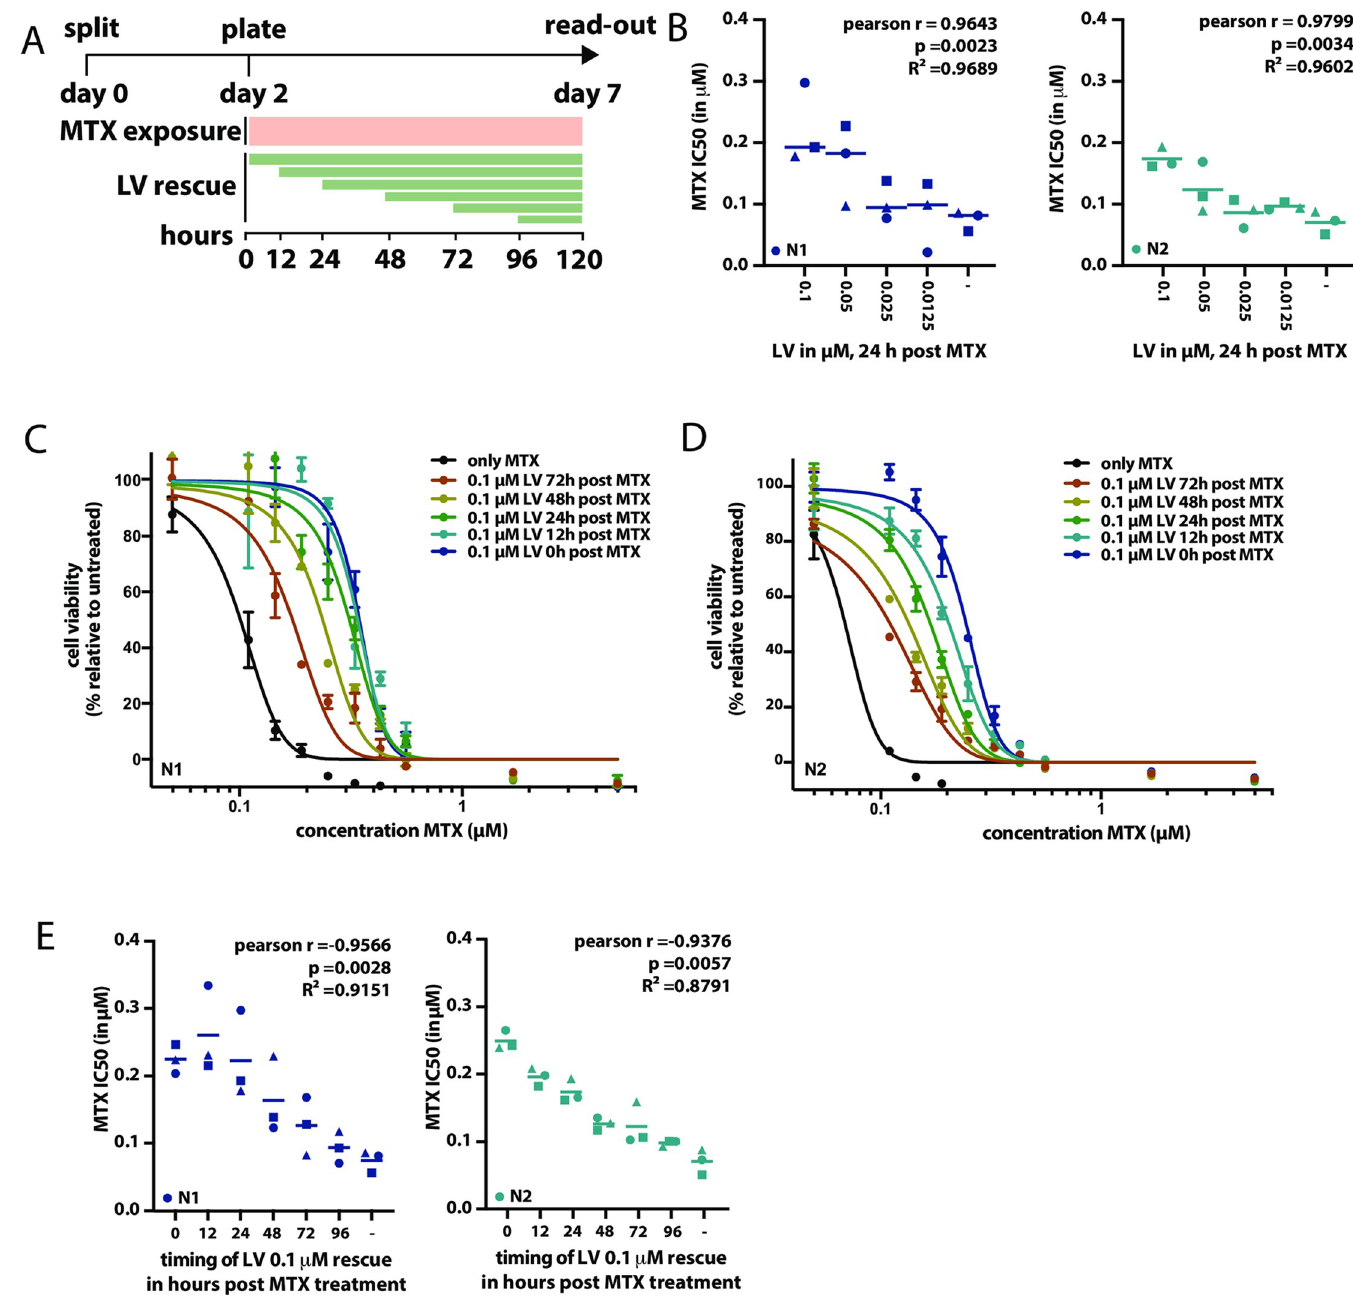
Fig 2. MTX-induced toxicity in oral mucosa organoids can be rescued by the addition of LV, in both a timing- and dosing-dependent manner. A. Schematic outline of the experimental set-up applied to assess the effect of LV rescue initiated post MTX exposure toxicity in vitro . Organoids were split on day 0, left to recover for two days, subsequently filtered, counted and plated in 384 well format to be exposed to MTX for five days (with or without LV added on variable timepoints after the start of MTX exposure). On day 7, viability readout was performed. As such, organoids were exposed to MTX for a total of five days. B. MTX-induced toxicity can be decreased by LV rescue and extent of LV rescue is dose dependent. MTX IC50 values were determined either without LV rescue, and with different LV rescue dosages (0.1 μ M, 0.05 μ M, 0.025 μ M and 0.0125 μ M), where rescue was initiated 24 hours post the start of MTX exposure. Each IC50 value is obtained for a 9-point dose titration of MTX, where the effect of each dose is tested in technical triplicate. Symbols indicate the different replicate experiments in which the IC50 were defined for different timepoints of LV rescue. As such, IC50 values indicated with the same symbol at different timepoints, were determined in the same experiment. Blue symbols indicate N1 organoids, turquoise symbols indicate N2 organoids. C. Timing of LV rescue influences its effect of MTX-induced toxicity in N1 organoids. Here, MTX kill curves are shown when 0.1 μ M LV rescue is initiated either 0, 12, 24, 48, 72 or 96 hours after the start of MTX exposure. D. Timing of LV rescue influences its effect of MTX- induced toxicity in N2 organoids. Here, MTX kill curves are shown when 0.1 μ M LV rescue is initiated either 0, 12, 24, 48, 72 or 96 hours after the start of MTX exposure. E. Effect of PT in N1 (blue symbols) and N2 (turquoise symbols) organoids when combined with LV rescue, initiated at different time-points post start of